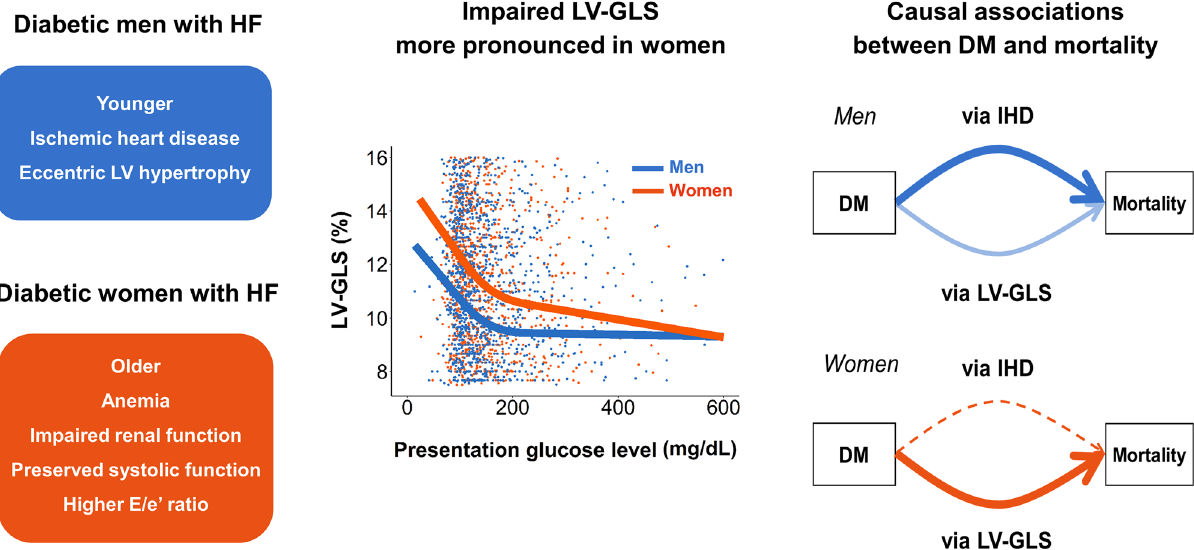
Figure 1. Sex-related differences in the impact of DM on phenotypes, LV-GLS, and causal associations in HF. The main findings of the study are summarized. ( Left ) Diabetic men and women with HF had different clinical and echocardiographic phenotypes. ( Middle ) The associations of presentation blood glucose level with the LV-GLS impairment were more pronounced in women. In the RCS curves, LV-GLS continually declined as hyperglycemia became severe in women, while it reached a plateau in men, resulting in the gradual convergence of the two curves. ( Right ) The main driver from DM to mortality differed; men had a larger effect via IHD than LV-GLS impairment, whereas effect mediating LV-GLS was the only predominant path in women. Dominant pathways are indicated by bold arrows; those with dashes arrows are statistically insignificant. DM = diabetes mellitus; HF = heart failure; IHD = ischemic heart disease; LV-GLS = left ventricular global longitudinal strain; RCS = restricted cubic patients 4 , and also associated with a worse prognosis 5 . These findings suggest the importance of detection and management of DM in individuals at risk for or with HF. On the other hand, accumulating evidence proposes that there are significant sex differences in the cardio- vascular consequences of DM, including the development of HF 6 . A recent meta-analysis demonstrated that the excess risk of HF associated with DM was significantly higher in women than in men 7 . Considering that HF in women occurred with less ischemic etiology than in men 8 , and ischemic heart disease (IHD) in diabetic patients had an especially deleterious impact on mortality 9 , it can be assumed that the prognosis of women with HF and DM might differ from men. However, there is a relative paucity of data on sex differences in the association of DM with clinical outcomes of HF, although most registries suggest that women with HF survive better than men with HF 10 . We hypothesized that the impact of DM on clinical and echocardiographic characteristics of patients with HF and their prognosis differs by sex. This study aimed to investigate the association of DM with left ventricular (LV) systolic function, measured as LV global longitudinal strain (LV-GLS), and mortality according to sex in HF patients, from the cohort of patients with acute HF.